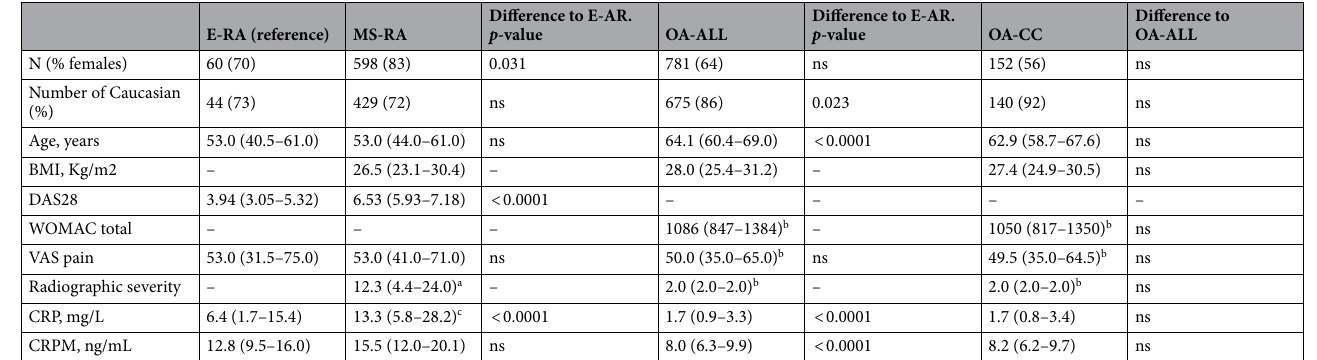
Table 1. Cohort descriptions including subjects with serum CRP and CRPM measurement available at baseline. Data is shown as numbers (%) or median (IQR). Differences between cohorts were tested with Mann–Whitney test or Chi-squared test. E-RA early RA cohort, MS-RA moderate-severe RA, OA-ALL the full OA cohort, OA-CC the case–control cohort, DAS28 disease activity score 28, VAS visual analog score, KL Kellgren-Lawrence grade. a RA erosion score. b WOMAC total, VAS pain and KL grade of the signal knee. c Adjusted from mg/dL to